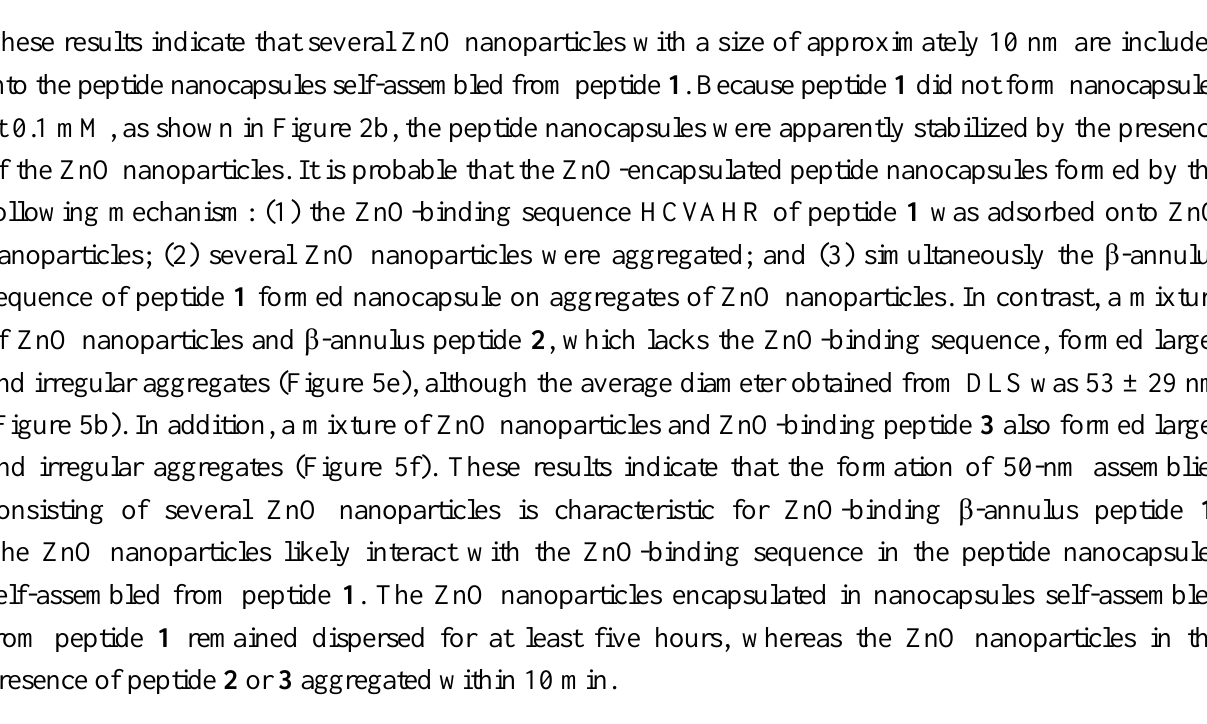
Figure 5. Size distribution obtained from DLS ( a – c ) and unstained TEM images ( d – f ) of ZnO nanoparticles in the presence of peptides ([ZnO] = [peptide] = 0.1 mM). ( a , d )